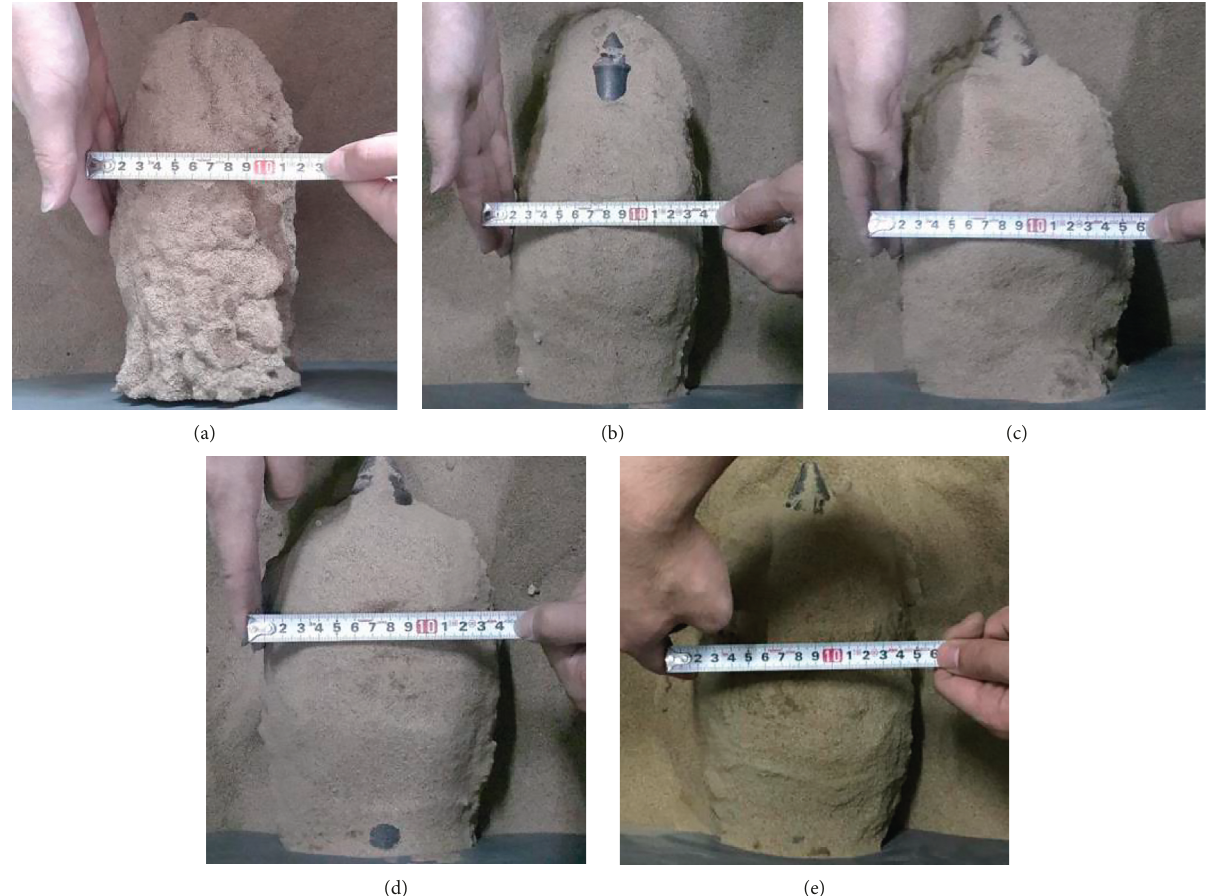
Figure 7: Concretions of the static pressure grouting under different grouting pressures. (a) 4kPa; (b) 5kPa; (c) 6kPa; (d) 8kPa; (e)